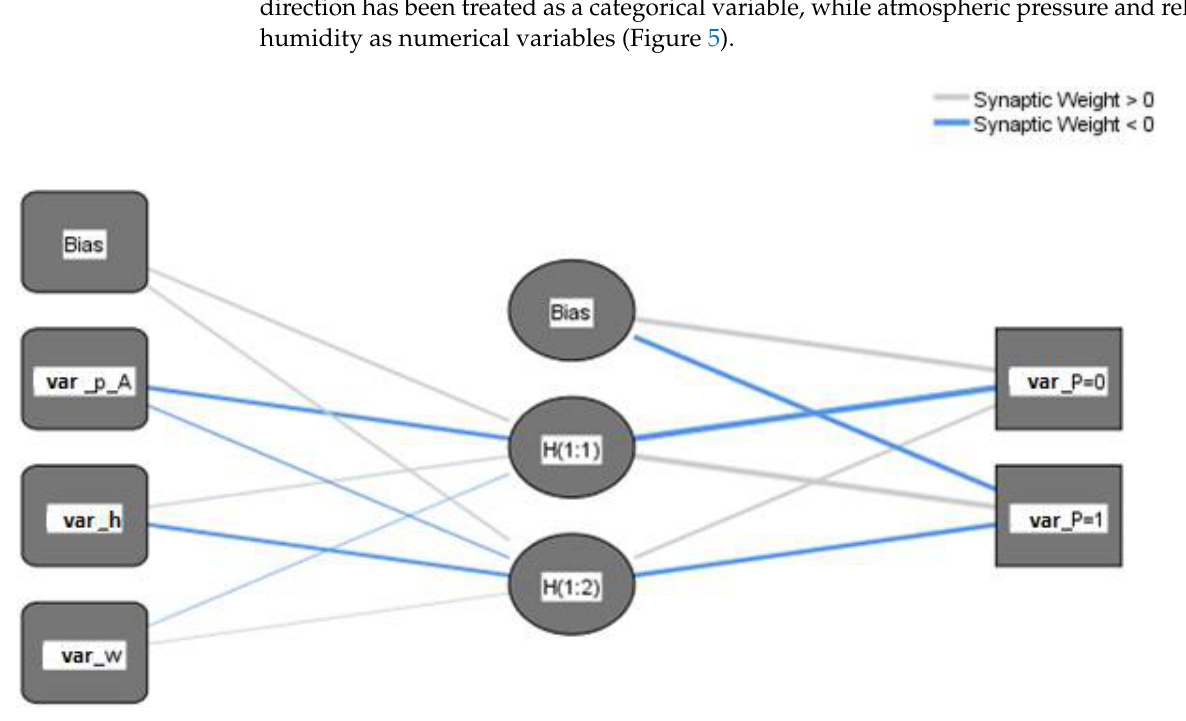
Figure 5. Network diagram of the aggregate model of all weather stations, where var_p_A is atmospheric pressure; var_h is humidity; var_w is wind; var_ p = 0 means no rainfall; var_ p = 1 means rain- fall.